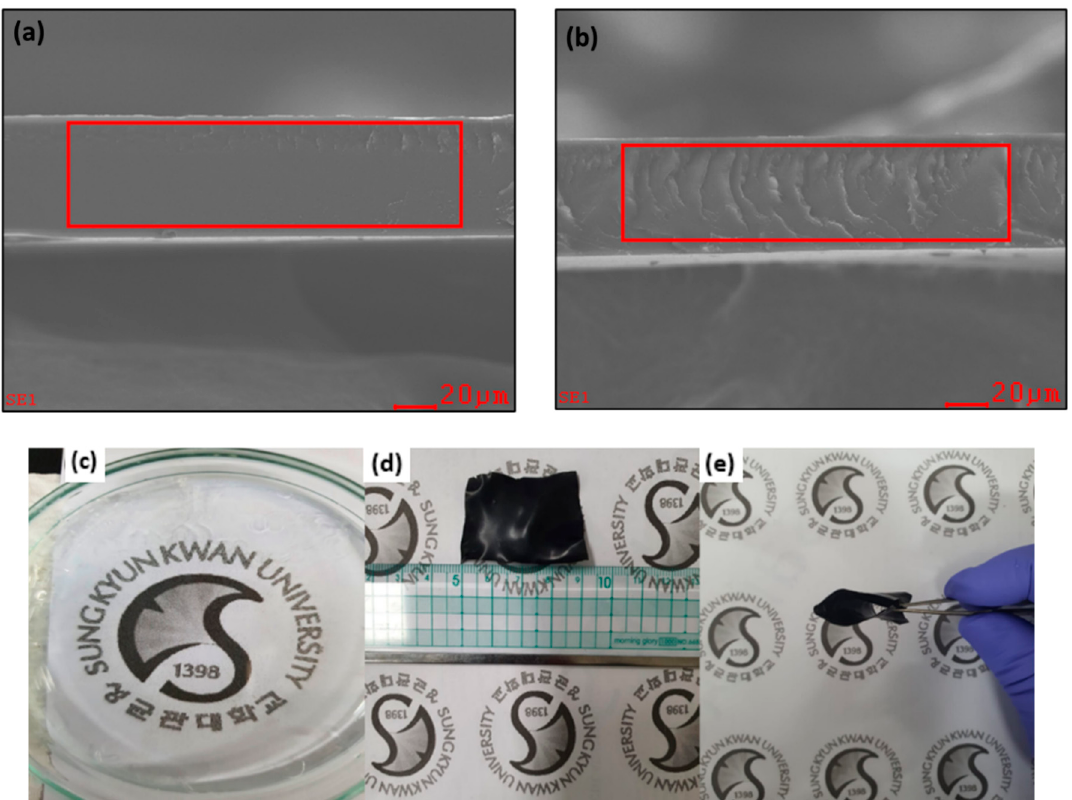
Figure 2. ( a , b ) FE-SEM images of pristine Nafion 212 and Nafion-GO/Ce ( c ) optical images of pristine and ( d , e ) composite membrane with the highest content.